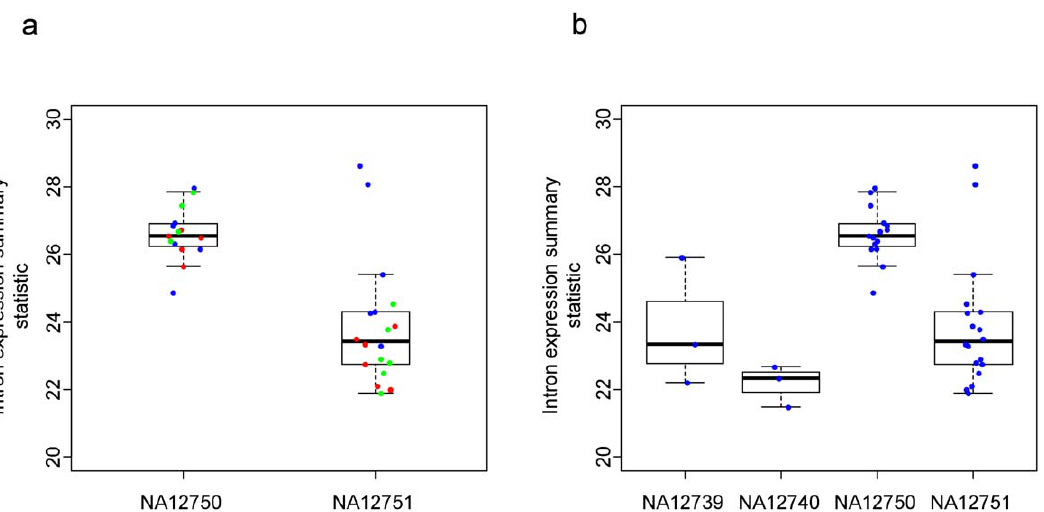
Figure 1. Reproducibility of the summary statistic of intron expression across replicate samples from a previous study. a) stripchart showing technical and biological replicates for two lymphoblast cell lines. Separate cell passages are shown in different colours. b) boxplots and superimposed stripcharts of biological replicates (separate cell passages) of four cell lines.